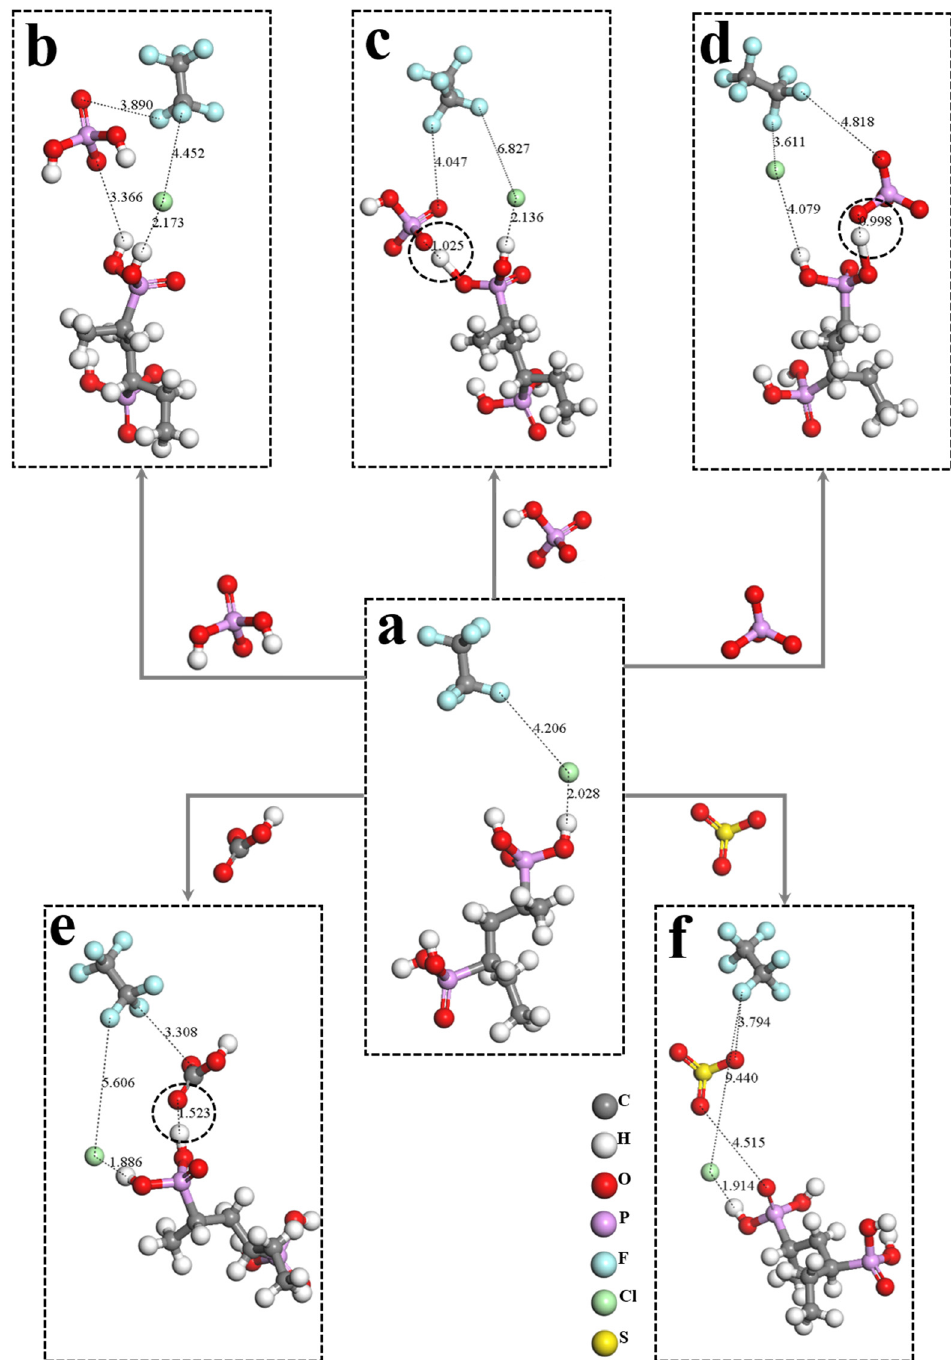
Figure 6. Intermolecular distance between the introduced anions and the PVPA chain and that between Na+ and the PVPA chain before and after the introduction of the anion: ( a ) Cl − -PVPA, ( b ) Cl − -PVPA and H 2 PO − -PVPA, ( c ) Cl − -PVPA and HPO 2 − -PVPA. The black dashed circle in ( c ) was the hydrogen bond between hydrogen and oxygen atom, ( d ) Cl − -PVPA and PO 3 − -PVPA. The black dashed circle in ( d ) was the hydrogen bond between hydrogen and oxygen atom, ( e ) Cl − -PVPA and HCO − -PVPA. The black dashed circle in ( e ) was the hydrogen bond between hydrogen and oxygen atom ( f ) Cl − -PVPA and SO 2 − 4